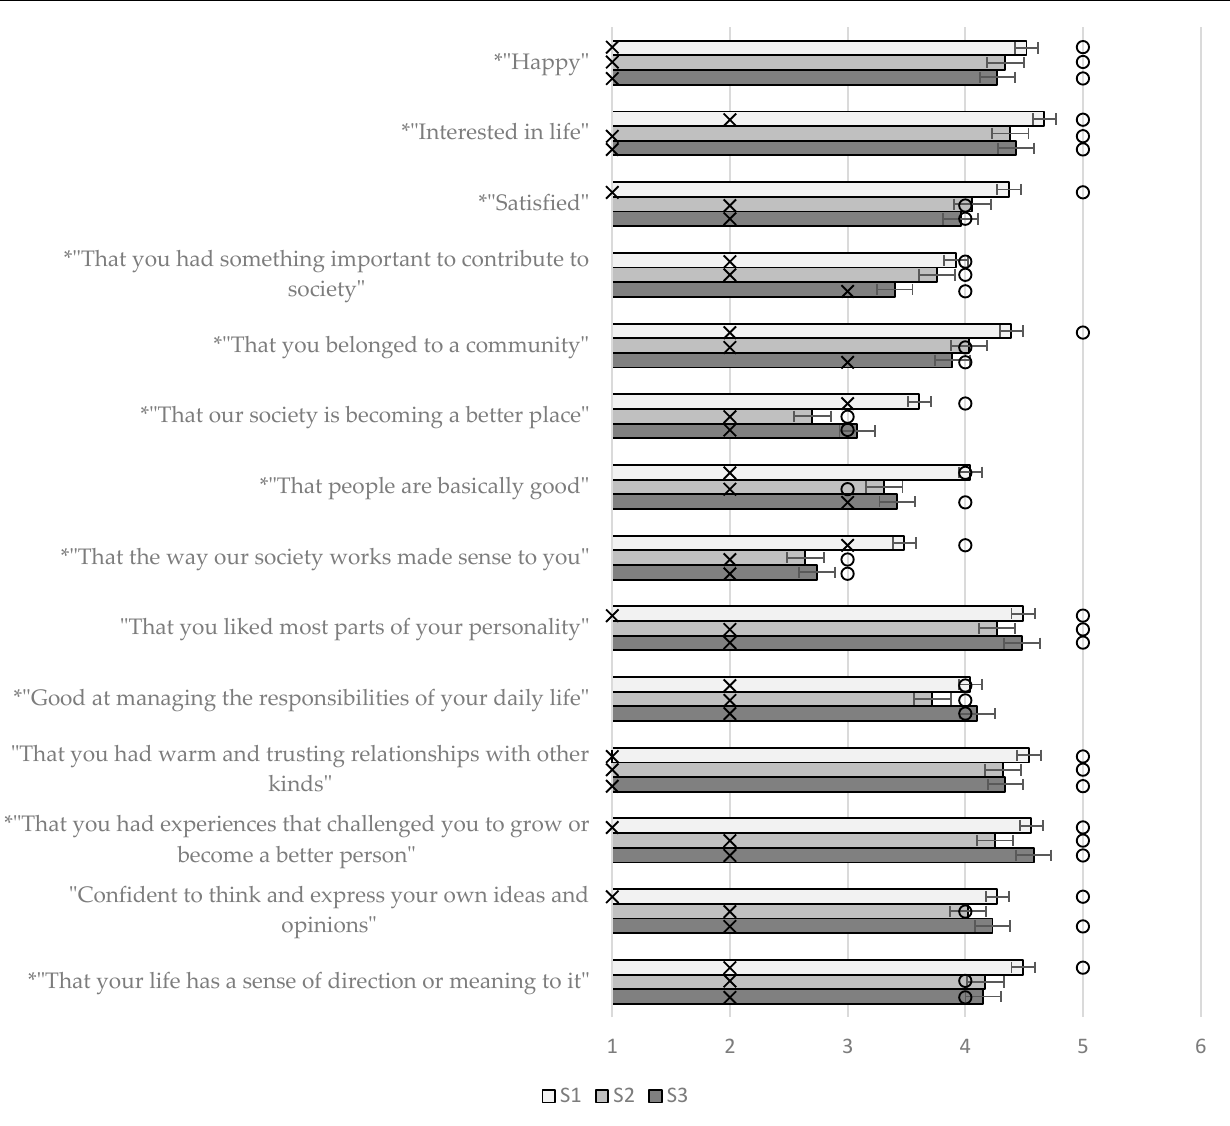
Figure 1. Means and standard error bars for the individual items of the MHC-SF; the IQR is repre- sented by an ‘x’, the median by a circle and an asterisk indicates a statistically significant difference in one or more groups.